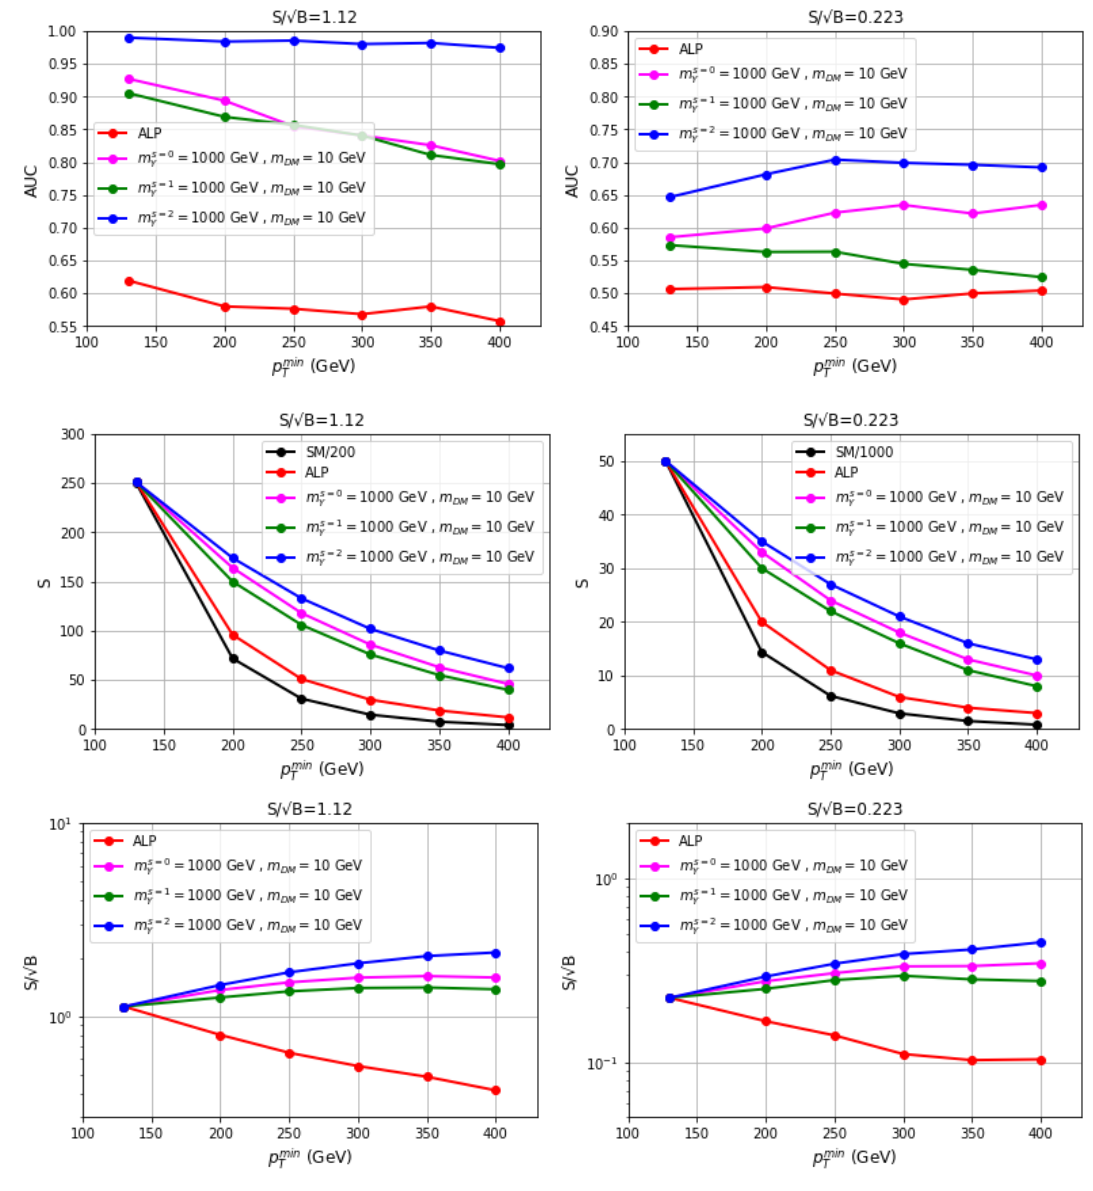
(cid:112) B per histogram, as a function of the selection cut p min Figure 29: AUC, S , and S / (first, second, and third row respectively), for two examples of S / = 130 GeV (see text for details). We assume fixed collider luminosity 0.223, at p min T and coupling values of each model, therefore for increasing p j ing amount of